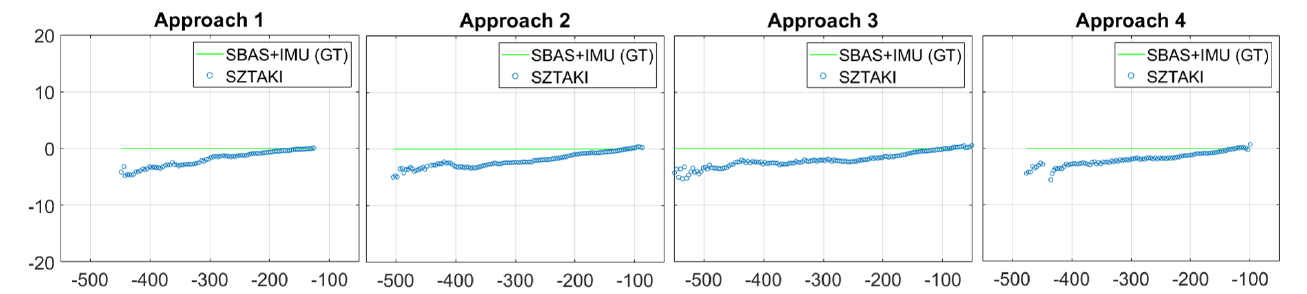
Figure 12. Lateral ( X R [ m ]) error of four consecutive runway approaches at Septfonds. Longitudinal distance is the largest in absolute value among the three runway relative position coordinates, thus the same or even better performance compared to lateral errors means better relative accuracy. Figure 13 presents the longitudinal errors for the four approaches which converges to cm deviation at 100 m. The last measurement of approach 4 with increased error comes from a partial detection of the runway marker (missing of the half of the marker is allowed, and marker goes out of FOV at the end of the approach). Table 1 summarizes the bias and standard deviation of optical navigation data. The bias is distance-dependent, thus standard deviations in the table are larger than the real disturbance (bias change added); however, in an error model we need to define a bias level (mean of errors inside the interval).